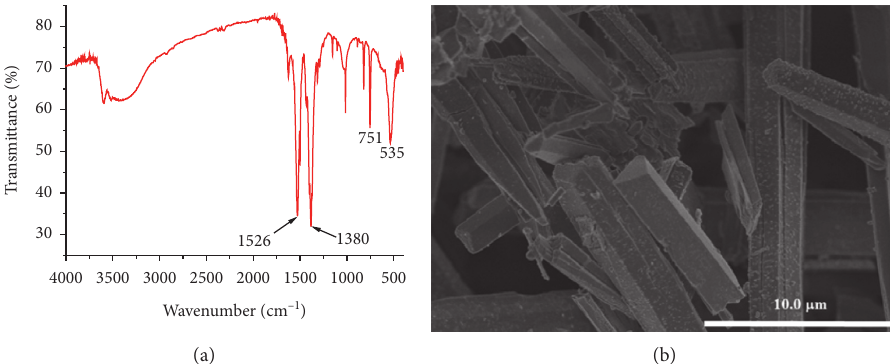
Figure 5: FT-IR spectra (a) and SEM image (b) of the iron (III) benzene dicarboxylate sample synthesized at 150 ° C and precursors/DMF molar ratio of 1:1:450.